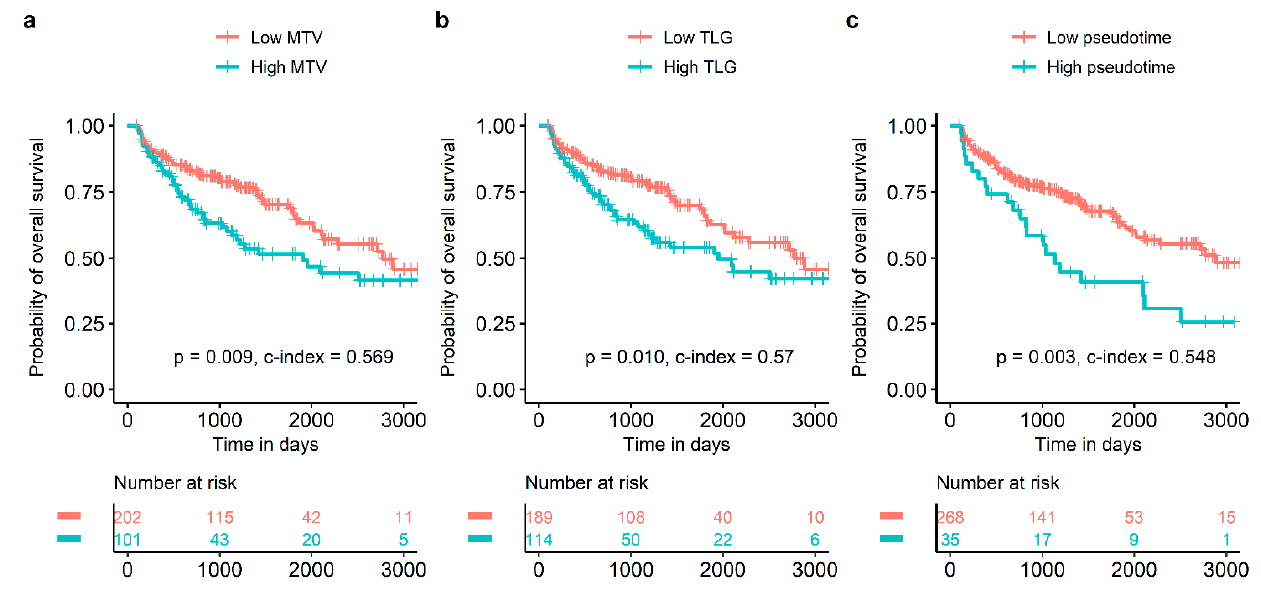
Figure 3. Survival curves according to MTV, TLG, and pseudotime. MTV ( a ), TLG ( b ), and pseudo- time ( c ) of the primary tumor were significant prognostic factors for overall survival.